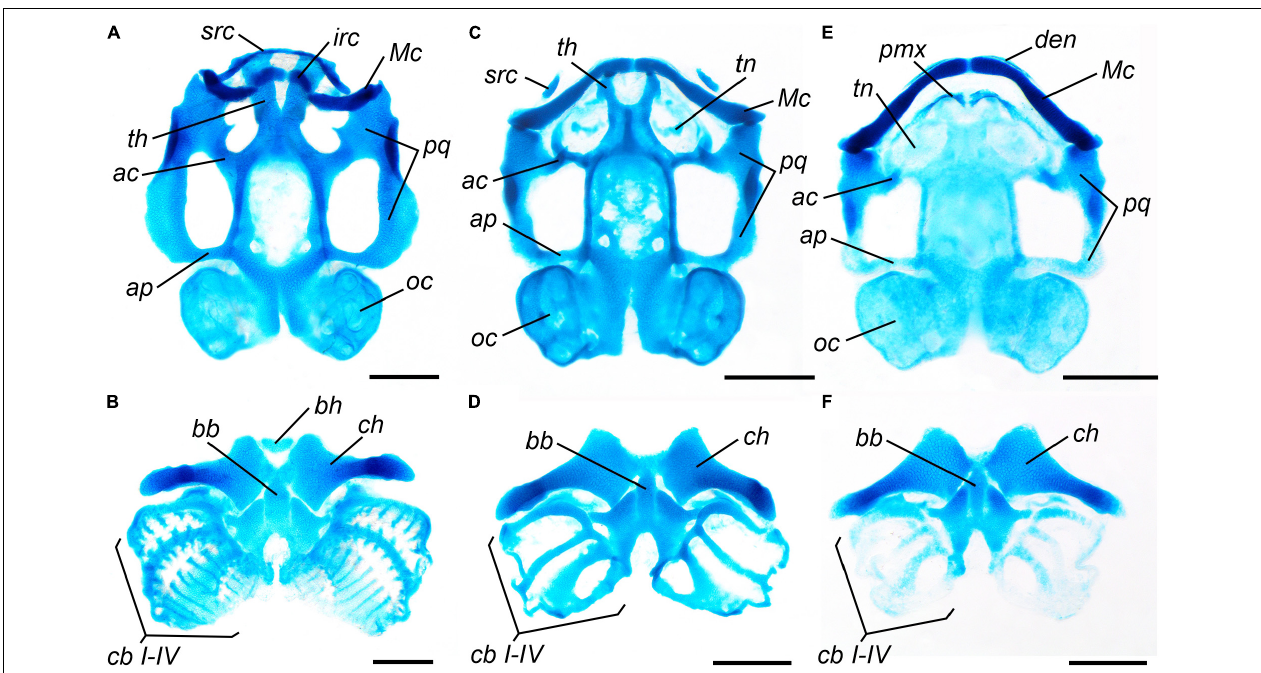
FIGURE 6 | Larval chondrocranium and hyobranchium of Bombina variegata in normally developing and TH-treated tadpoles: (A,B) norm, Stage 35, 15 dph; (C,D) after 9 days of treatment with T 3 2 × 10 − 8 M, limb development corresponding to Stage 35, 15 dph; (E,F) after 11 days of treatment with T 3 2 × 10 − 8 M, limb development corresponding to Stage 35, 17 dph. Abbreviations: ac , anterior commissure of palatoquadrate; ap , ascending process of palatoquadrate; bb , basibranchial; bh , basihyal; cb , ceratobranchials; ch , ceratohyal; den , dentary; irc , infrarostral cartilage; Mc , Meckelian cartilage; oc , otic capsule; pmx , premaxilla; pq , palatoquadrate; src , suprarostral cartilage; tn , tectum nasi; th , trabecular horns. Scale bar 1